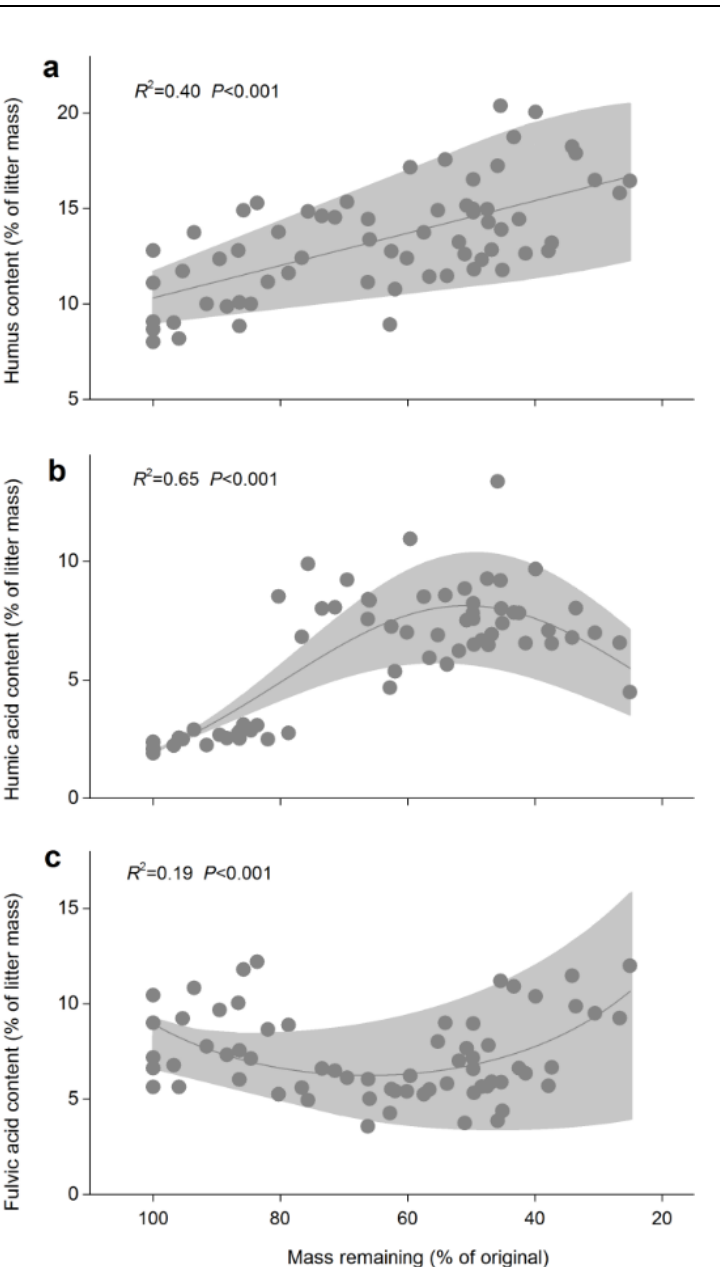
Figure 2. Humus contents (±SE, n = 6) in the five foliar litters. ( a ) Cypress, ( b ) larch, ( c ) birch, ( d ) willow and ( e ) azalea. SF: snow formation stage, SC: snow cover stage, SM: snowmelt stage, GS: